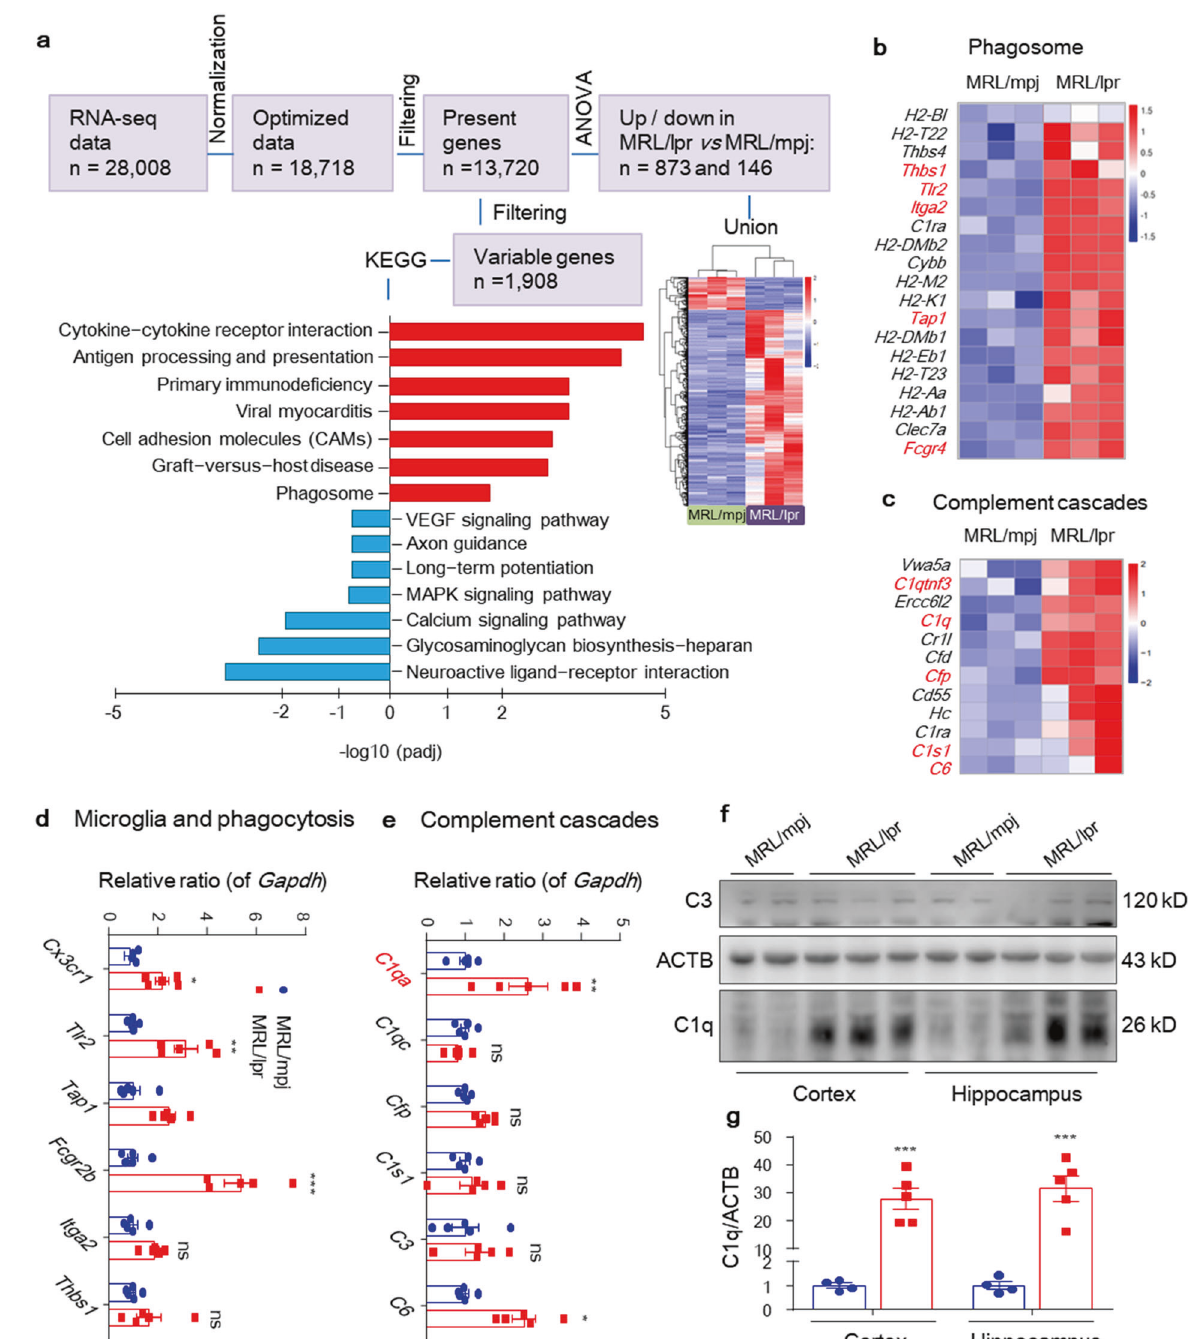
Fig. 2 Transcriptional pro fi le revealing increased phagocytosis and complement signal activation in the MRL/lpr mouse brain. a Work fl ow of RNA-seq data analysis of the hippocampus in MRL/lpr and MRL/mpj mice, with a heat map of differentially expressed genes. The bar chart displays 1908 variable genes, which are some of the corresponding KEGG terms and have higher expression in the MRL/mpj- or MRL/lpr- hippocampus (bottom). KEGG, Kyoto Encyclopedia of Genes and Genomes. b and c Heat maps showing the relative expression of signi fi cantly altered genes (see “ Methods ” ) generated from the hippocampal RNA-seq of MRL/mpj vs. MRL/lpr mice at 6 weeks of age. Each column represents an individual mouse. d and e Validation of select genes and pathways in a unique set of mice by qPCR. n = 5 – 6 mice per group. f and g Immunoblotting validation of C3 and C1q in the cortex and hippocampus of 6-week-old MRL/mpj ( n = 4) and MRL/lpr ( n = 5) mice.The data are the mean ± SEM. * P < 0.05; ** P < 0.01; *** P < 0.001; and ns, not signi fi cant according to one-way ANOVA with Tukey ’ s post hoc test in ( d ), ( e ), ( g ). See also Supplementary Figs. 3 and 4 neuronal system targets in the brain (Supplementary Fig. 3b, c), further fi ltering of 1019 transcripts (873 upregulated, 146 which was consistent with clinical biomarkers related to downregulated in MRL/lpr; cutoff of 1.5-log 2 fold change; NPSLE. In addition, KEGG pathway analysis revealed signatures adjusted P < 0.05). Enriched reactome pathway analysis showed of cytokine-cytokine receptor interaction, antigen processing and that MRL/lpr mice exhibited increased SLE signaling and reduced Signal Transduction and Targeted Therapy (2022)